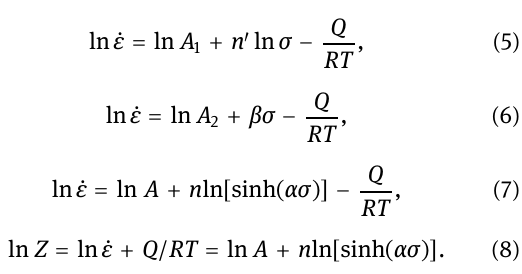
rate values in equations ( 5 ) and ( 6 ) . Scatter diagrams and